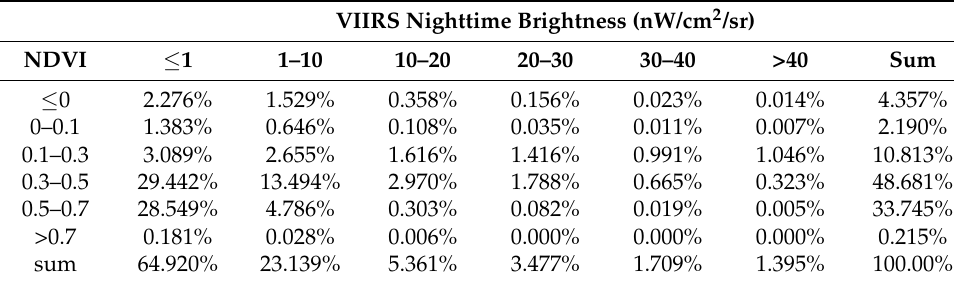
Table 1. Matrices for distribution of NDVI and VIIRS nighttime